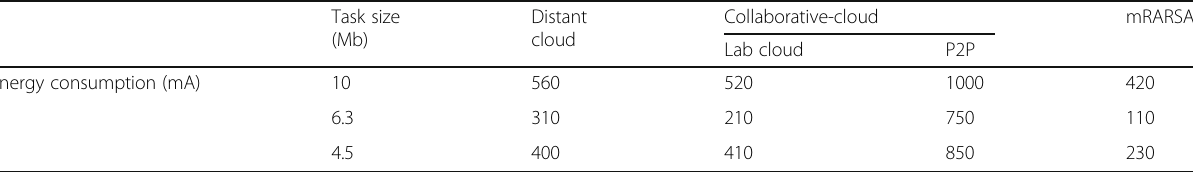
Table 12 Energy consumption performance